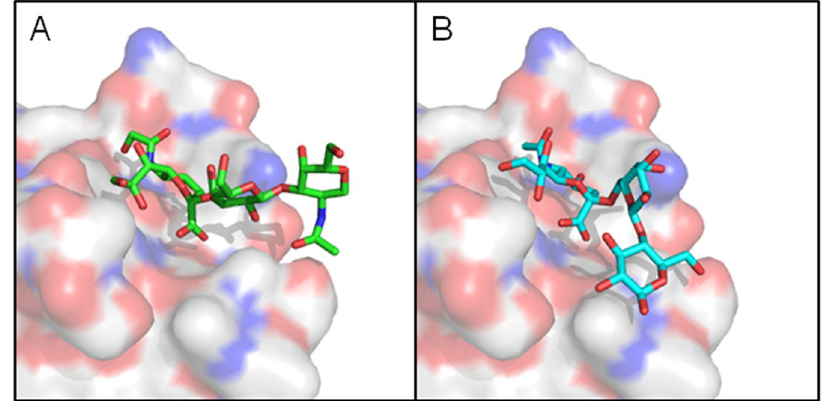
Figure 1. Surface representation of SubB in complex with ( A ) Neu5Gc α 2–3Gal β 1–3GlcNAc (determined from a X-ray crystal structure (Byres et al . 8 )) and ( B ) Neu5Gc α 2–6Gal β 1–3Glc (modeled with the X-ray crystal structure). Trisaccharides are shown as a green or cyan stick with red and blue residues representing oxygen and nitrogen,